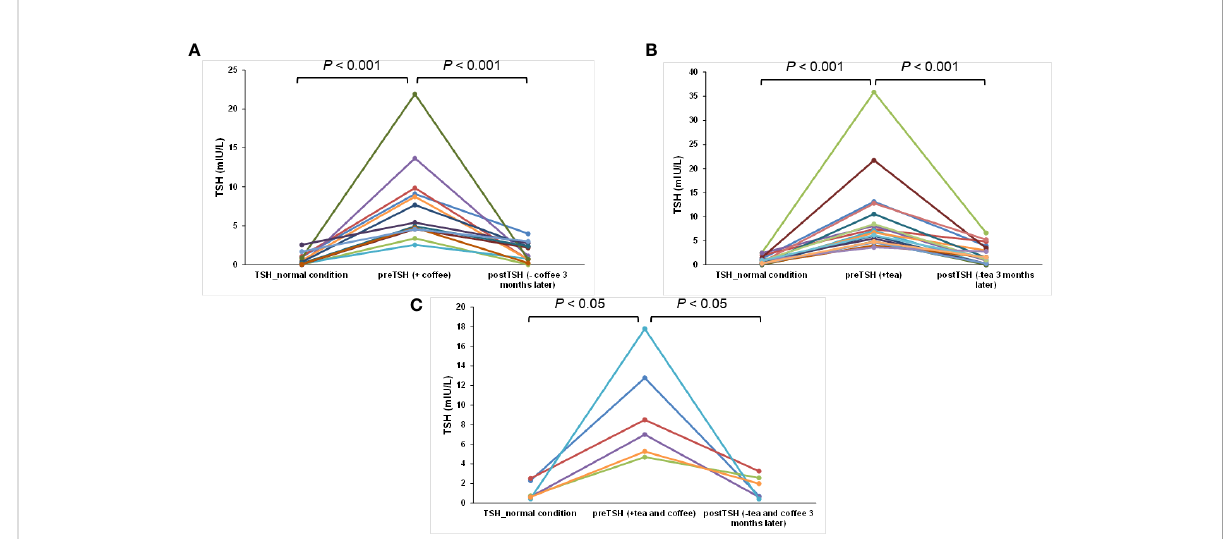
FIGURE 1 The time course for TSH changes for each patient for normal conditions, regular tea and/or coffee consumption within 1 h of LT4 intake, and coffee/tea consumption at least 4 h after swallowing LT4: (A) only coffee, (B) only tea, and (C) both coffee and tea groups.